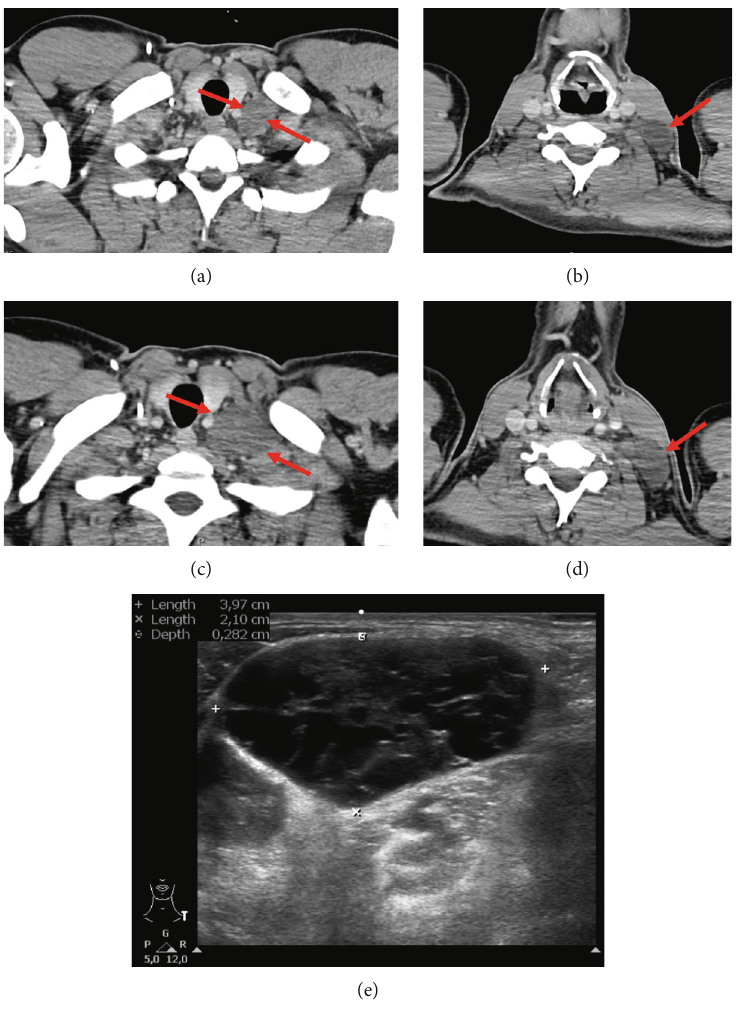
Figure 6: CT and ultrasound. Axial thoracic contrast-enhanced CT images at 2-month (a, b) and 5-month follow-up (c, d), showing progressive enlargement of left cervical lymph nodes with di ff use hypodensity (red arrows). (d) Ultrasound image of the same left cervical lymph node depicted on the CT images (a – d) at the microbiopsy, which showed mixed echogenicity, being primarily hypoechogenic with some echogenic